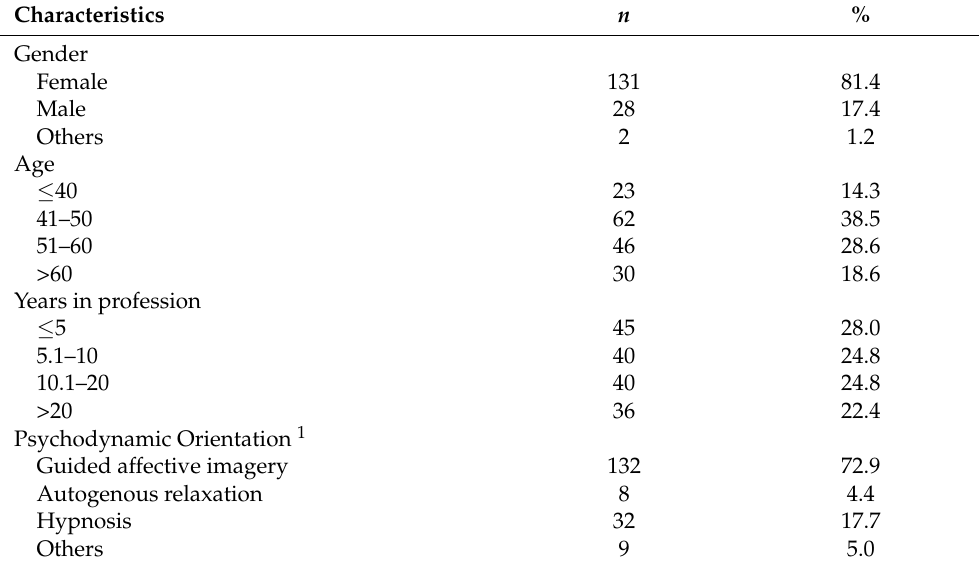
Table 1. Sociodemographic characteristics of the